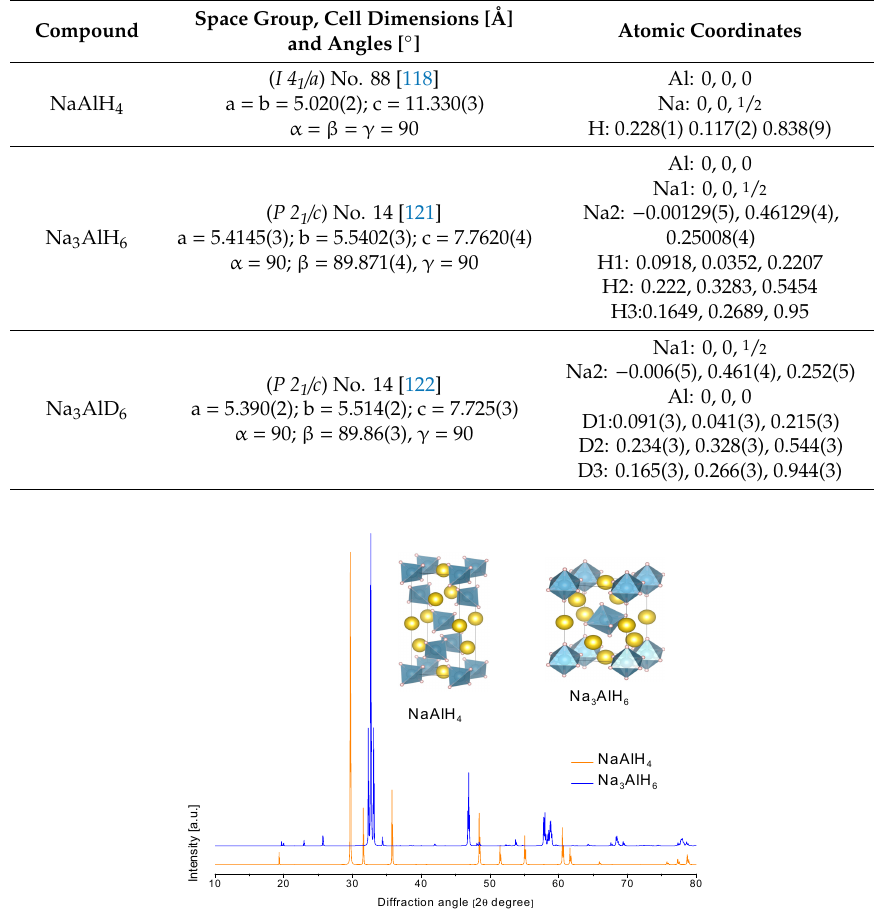
Table 3. Crystallographic data of Na-alanates.